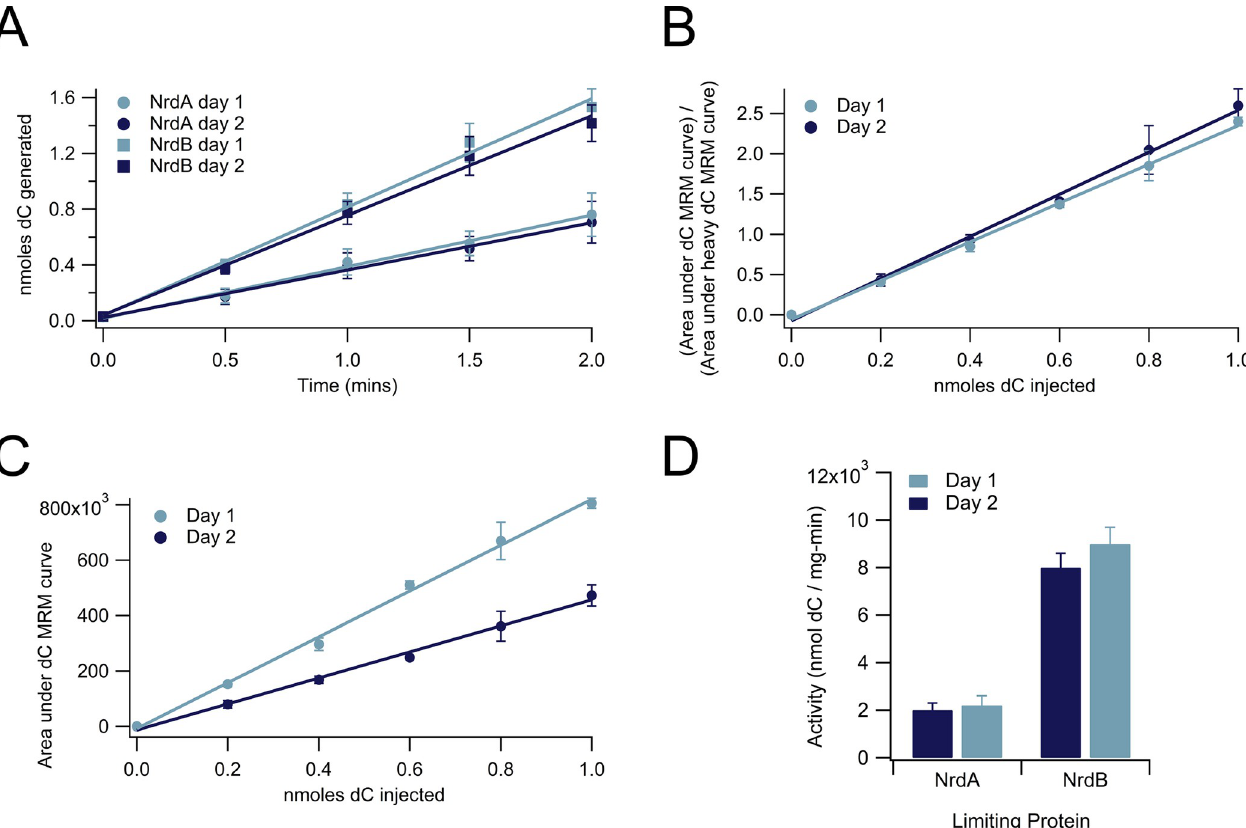
Fig 6. The use of internal standards eliminates the need for same-day standard curves. (A) Standard curves of the same amount of dC (0–1 nmole) run on the mass spectrometer on two different days (day 1 and day 2). (B) Standard curves run on day 1 and day 2 after internal standard correction (the area under the MRM curve of the heavy [ 13 C/ 15 N] dC nucleoside). (C) Activity assay data for Ec NrdA and Ec NrdB with nmoles dC calculated after correction of both standard and sample dC integration using a heavy dC internal standard. Both assays were run on day 2 along with the day 2 standard curve used for day 2 activity calculation; day 1 standard curve used for day 1 activity calculation was run on a previous day. (D) Calculation of activity from curves in (C) with Ec NrdA or Ec NrdB as the limiting reagent. NrdA activity was determined to be 2000 ± 300 nmoles dC/mg-min using the day 2 standard curve to calculate activity and 2200 ± 400 nmoles dC/mg-min using the day 1 standard curve to calculate activity. NrdB activity was determined to be 8000 ± 600 nmoles dC/mg- min using the day 2 standard curve to calculate activity and 9000 ± 700 nmoles dC/mg-min using the day 1 standard curve to calculate activity. The above conditions contained NrdA (0.1 μ M dimer for NrdA condition and 0.5 μ M dimer for NrdB condition), NrdB (0.5 μ M dimer for NrdA condition and 0.1 μ M dimer for NrdB condition), ATP (3000 μ M), CDP (1000 μ M), Trx (30 μ M), TrxR (0.5 μ M), and NADPH (200 μ